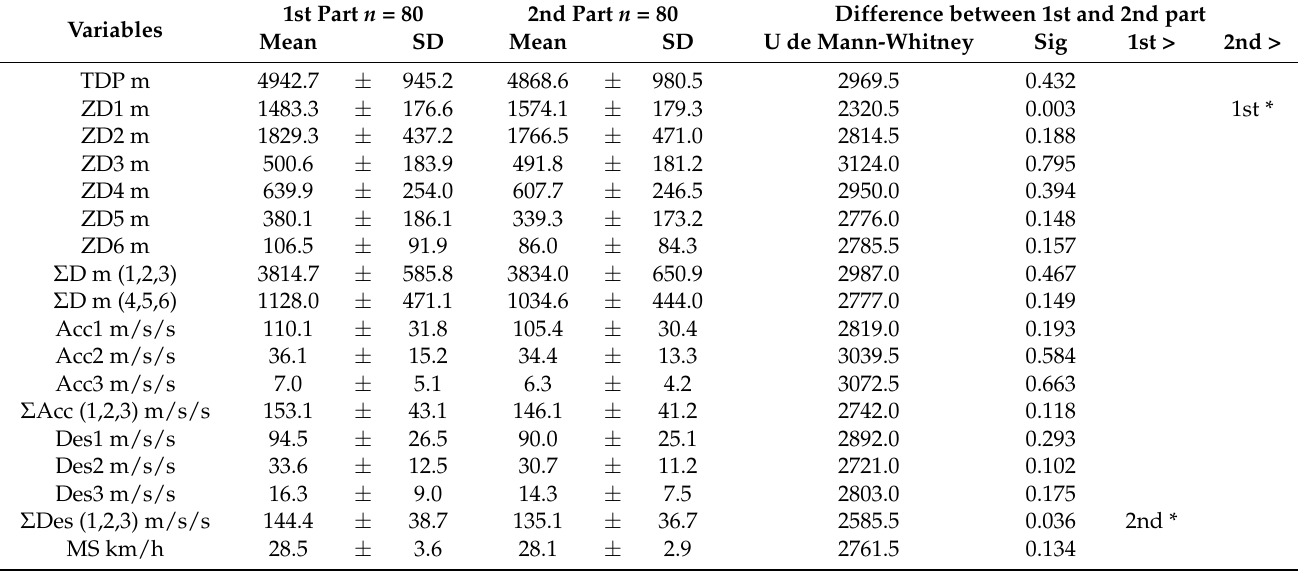
Table 5. Distances covered across each speed threshold according to first and second half (data are reported as mean ± SD). Variables